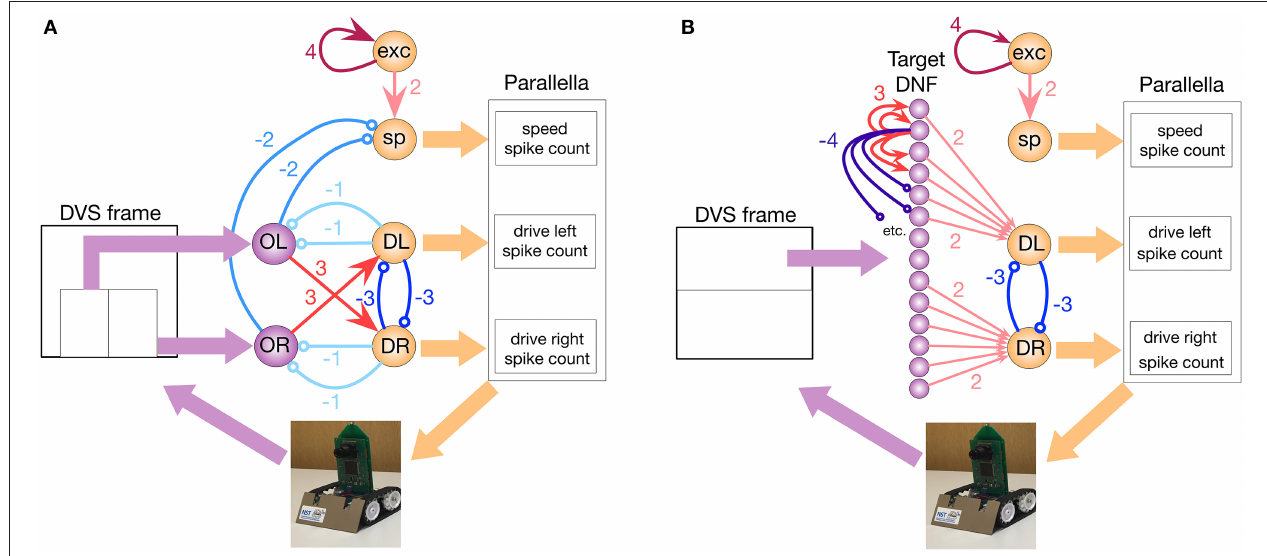
FIGURE 4 | The implemented neuronal architectures for obstacle avoidance and target acquisition. (A) Obstacle avoidance: Violet OL and OR circles represent obstacle detecting neuronal populations. Orange DL and DR circles are motor driving populations. sp is the speed-setting population, and exp is the constantly firing population that sets the default speed. Thin arrows show excitatory non-plastic connections realized on the ROLLS chip, whereas colors and numbers show the weights (the exact value of the weight is set by the biases, listed in Table 2) in Appendix B (Supplementary Material). (B) Target acquisition: Same notations. The violet line of circles shows a DNF population that represent targets. On the chip, both architectures are realized at the same